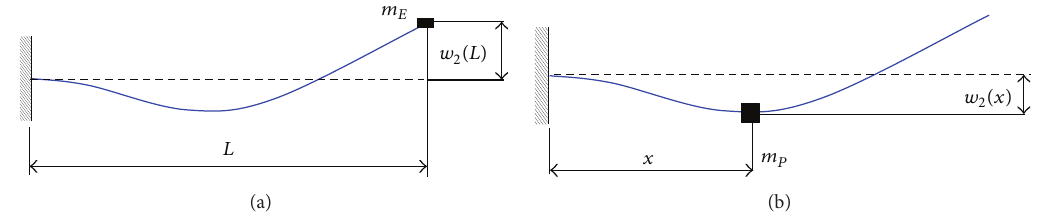
Figure 3: Dynamically equivalent systems having the mass located at different positions.